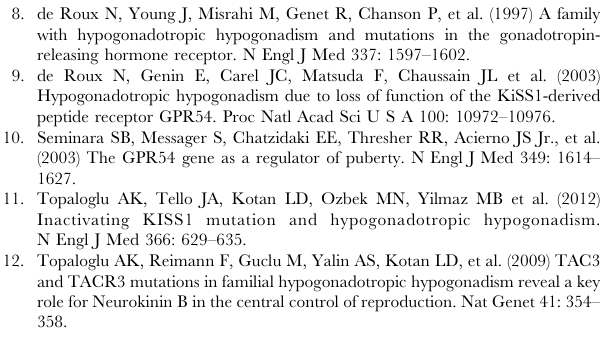
as compared to WT littermates (white bars). Numerical data used to generate these two graphs may be found in Table S5. Figure S5 Growth curve of nes-Cre;Dmxl2 –/wt male mice as compared to their WT littermates Dmxl2 lox/wt mice. Numerical data used to generate this graph may be found in Table S6. Figure S6 Quantification of corticotropin-releasing hormone (CRH) and thyrotropin-releasing hormone (TRH) mRNA levels in the hypothalamus of nes-Cre;Dmxl2 –/wt mice. Hypothalami of nes- Cre;Dmxl2 –/wt and Dmxl2 lox/wt mice were dissected, and total RNA was extracted as described in ‘‘Materials and Methods.’’ Levels of CRH and TRH mRNA were assessed by quantitative RT-qPCR. Primer sequences are available on request. CRH, corticotropin- releasing hormone; TRH, thyrotropin-releasing hormone. White bars, Dmxl2 lox/wt mice; black bars, nes-Cre;Dmxl2 –/wt mice. Numerical data used to generate these two graphs may be found in Table S5. Figure S7 Investigation of gait and exploratory behavior in nes- Cre;Dmxl2 –/wt mice. The Neogait Openfield system was used for automatic measurement of the gait and exploratory behavior of Dmxl2 lox/wt and nes-Cre;Dmxl2 –/wt mice. Gait was assessed by measuring two variables: distance from the starting point to the end point and the distance covered (number of blocks occupied). No significant differences in gait were found between any of the genotypes tested. However, there was a significant difference in the number of blocks occupied, indicating higher levels of exploratory behavior in nes-Cre;Dmxl2 –/wt mice than in their WT littermates. This difference disappeared in the second trial, suggesting a possible effect of fatigue, as the two trials were separated by an interval of only about 20 min. White and black bars represent the means of blocks occupied in trials 1 and 2 by nes-Cre;Dmxl2 –/wt mice or their WT litter mates, respectively (see numerical data in Table S5). Table S1 Body weight in nes-cre;Dmxl2 tm1a/wt mice. The body significantly different. PND, postnatal day. Table S2 Fertility analysis in nes-Cre; Dmxl2 tm1a/wt mice. Total number of litters, pups, sex of pups, genotype of pups, and mean litter size for all mice analyzed for this study over a 6-mo period. Table S3 Fertility tests in nesCre; Dmxl2 –/wt mice.